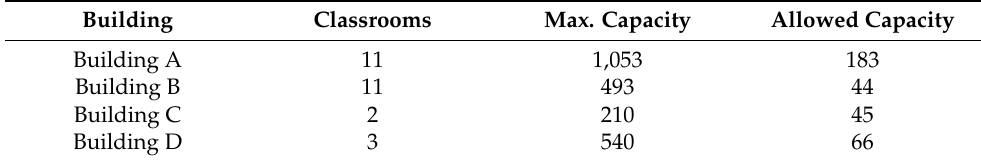
Table 6. Building’s occupation.